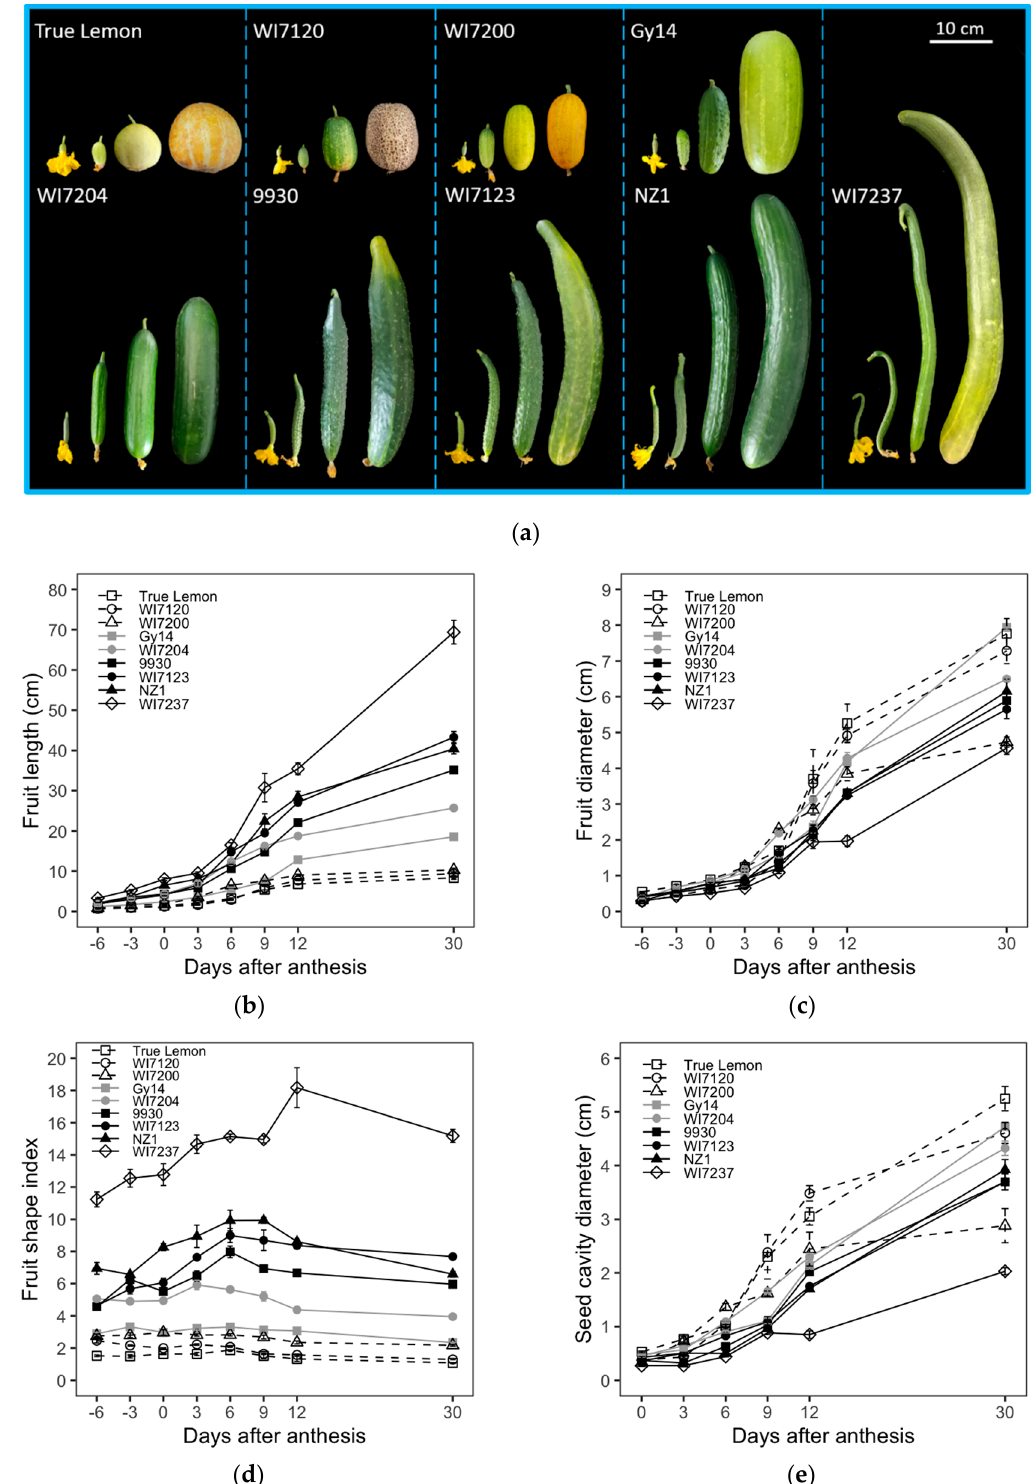
Figure 1. Dynamic changes of fruit size and shape related traits among nine typical cucumber inbred lines. ( a ) The ovary and fruit pictures of these 9 cucumber inbred lines, which were taken at 0, 6, 12 and 30 DAA, respectively. ( b – e ) The dynamic changes in fruit length (FL), diameter (FD), fruit shape index (FSI), and seed cavity diameter (SCD), respectively. Each value is the mean ± SE of 3 fruits.